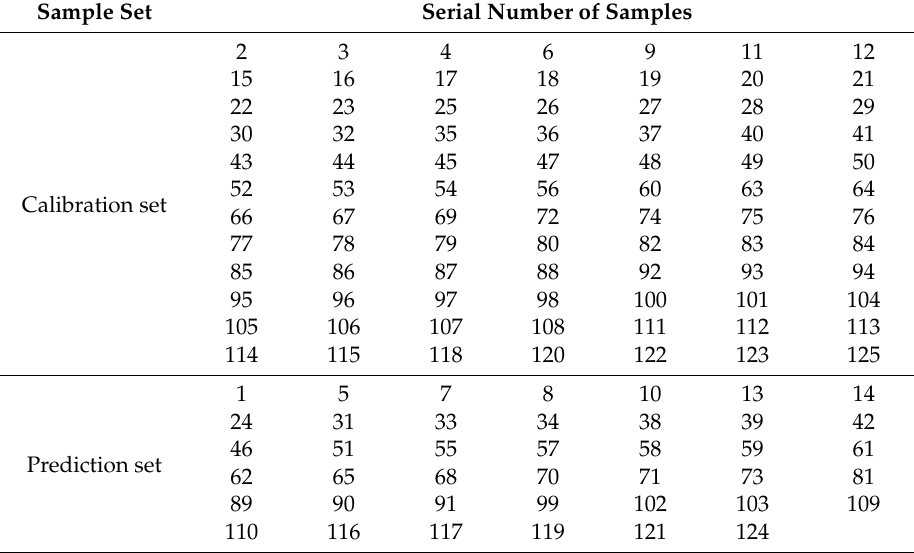
Table 1. The results of sets partition by improved K-S method.